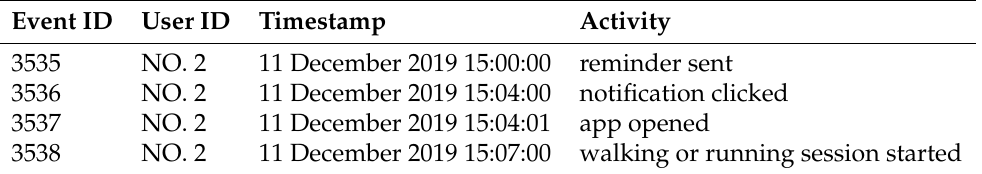
Table 3. Example data records indicate the behaviors of a user after receiving a